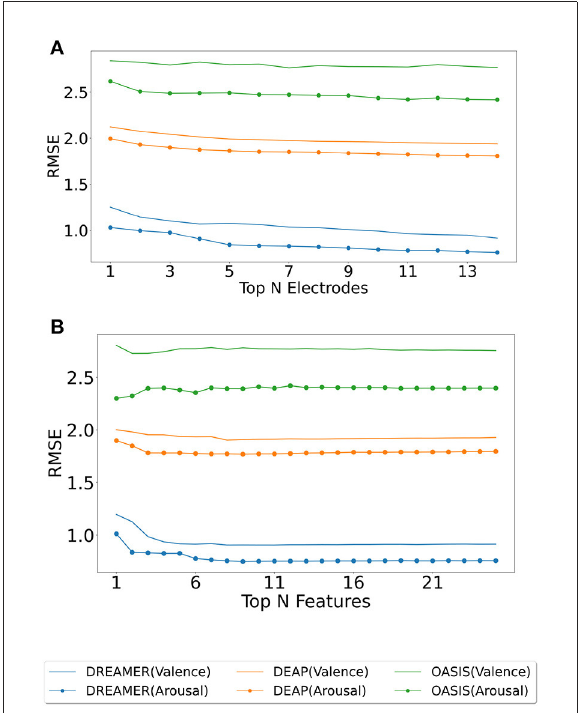
FIGURE3 Model evaluation for feature and electrode selection. The random forest regressor was trained on the training set (80%) corresponding to top N electrodes (ranked using SelectKBest feature selection method), and RMSE was computed on the test set (20%) for valence (plain) and arousal (dotted) label on DREAMER, DEAP, and OASIS EEG datasets as shown in (A) . A similar analysis was performed for top N features for DREAMER, DEAP, and OASIS EEG datasets, as shown in (B)